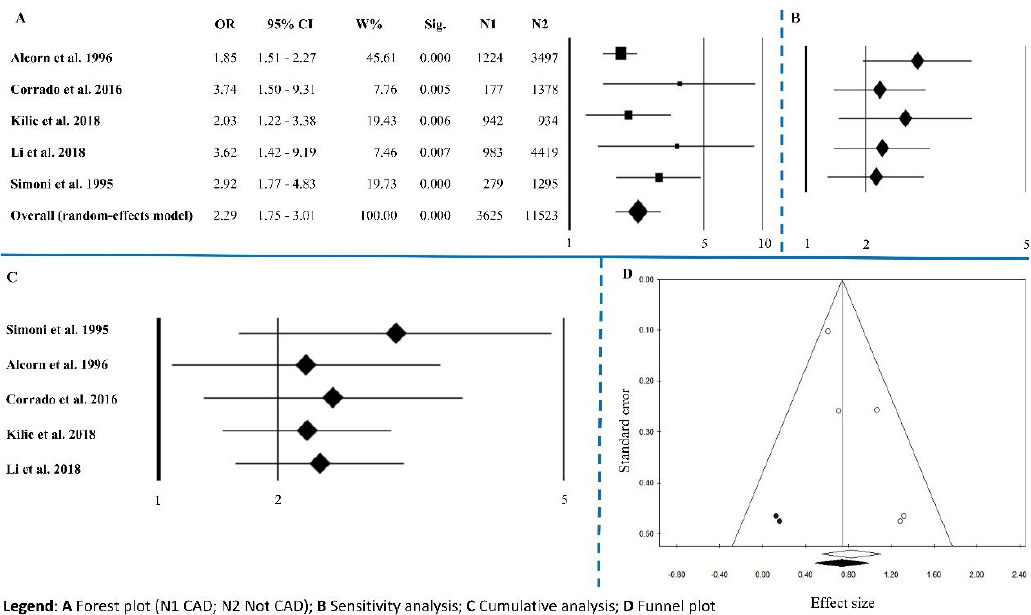
Figure 6. Coronary Artery Diseases (CAD). ( A ) Forest plot (N1 CAD; N2 Not CAD); ( B ) sensitivity analysis; ( C ) cumulative analysis; ( D ) funnel plot.